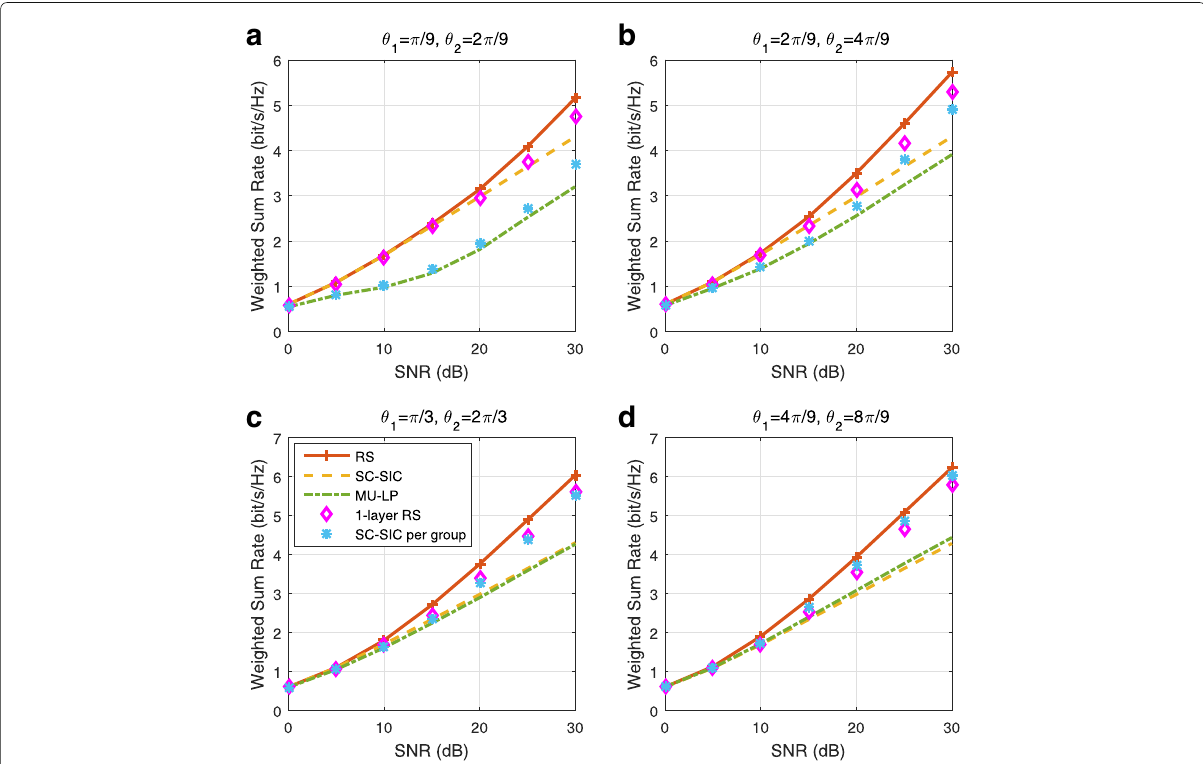
Fig. 16 Weighted sum rate versus SNR comparison of different strategies for overloaded three-user deployment with perfect CSIT, γ 1 = 1, γ 2 = 0.3, u 1 = 0.4, u 2 = 0.3, u 3 = 0.3, N t = 2, r th = [0.02,0.08,0.19,0.3,0.4,0.4,0.4] bit/s/Hz. a θ 1 = π/ 9, θ 2 = 2 π/ 9. b θ 1 = 2 π/ 9, θ 2 = 4 π/ 9. c θ 1 = π/ 3, θ 2 = 2 π/ 3. d θ 1 = 4 π/ 9, θ 2 = 8 π/